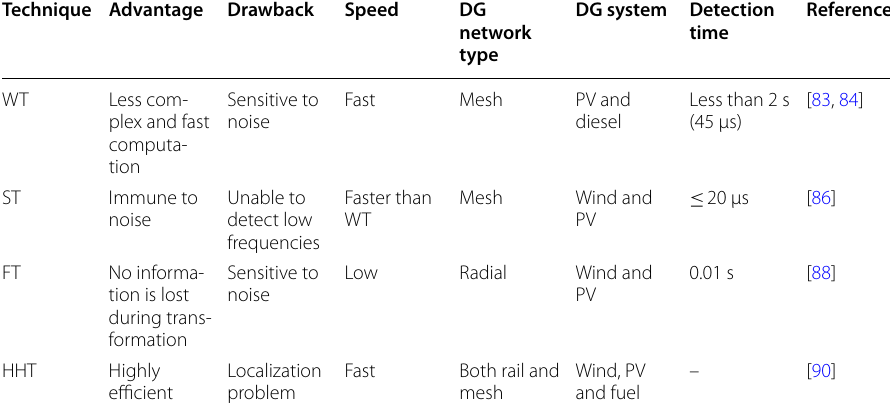
Table 5 Summary of various signal processing-based island detection technique Technique Advantage